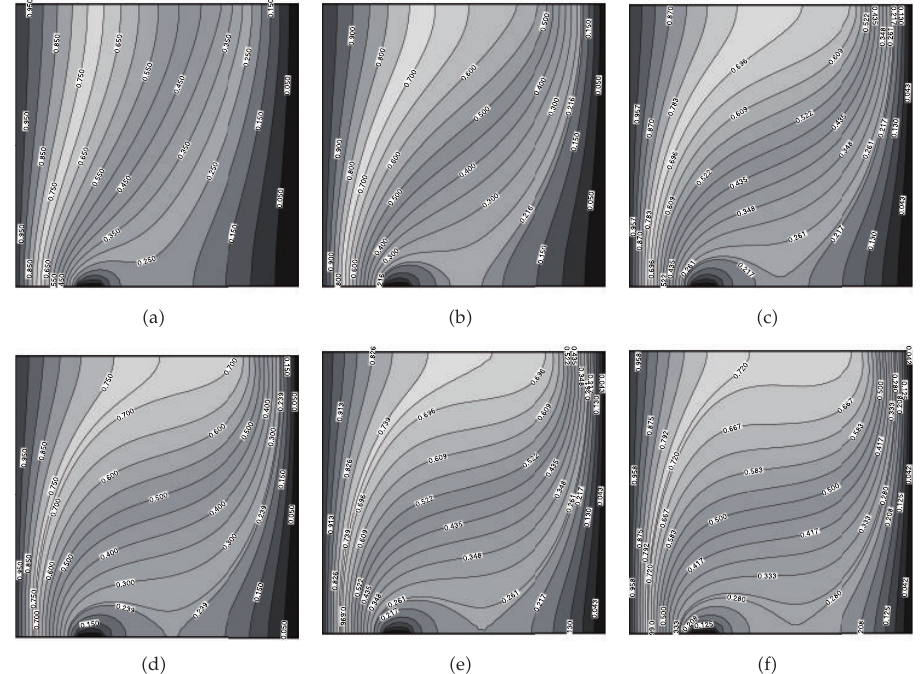
Figure 21: Isotherm contours along the left vertical wall while fixing B (cid:8) 1, (cid:2) D/H (cid:3) (cid:8) 0 . 1, a (cid:8) 0 . 1, Ra (cid:8) 100, S C (cid:8) 0 . 1 for (cid:2) a (cid:3) Ra (cid:8) 10, (cid:2) b (cid:3) Ra (cid:8) 25, (cid:2) c (cid:3) Ra (cid:8) 50, (cid:2) d (cid:3) Ra (cid:8) 75, (cid:2) e (cid:3) Ra (cid:8) 100, (cid:2) f (cid:3) Ra (cid:8) 150.